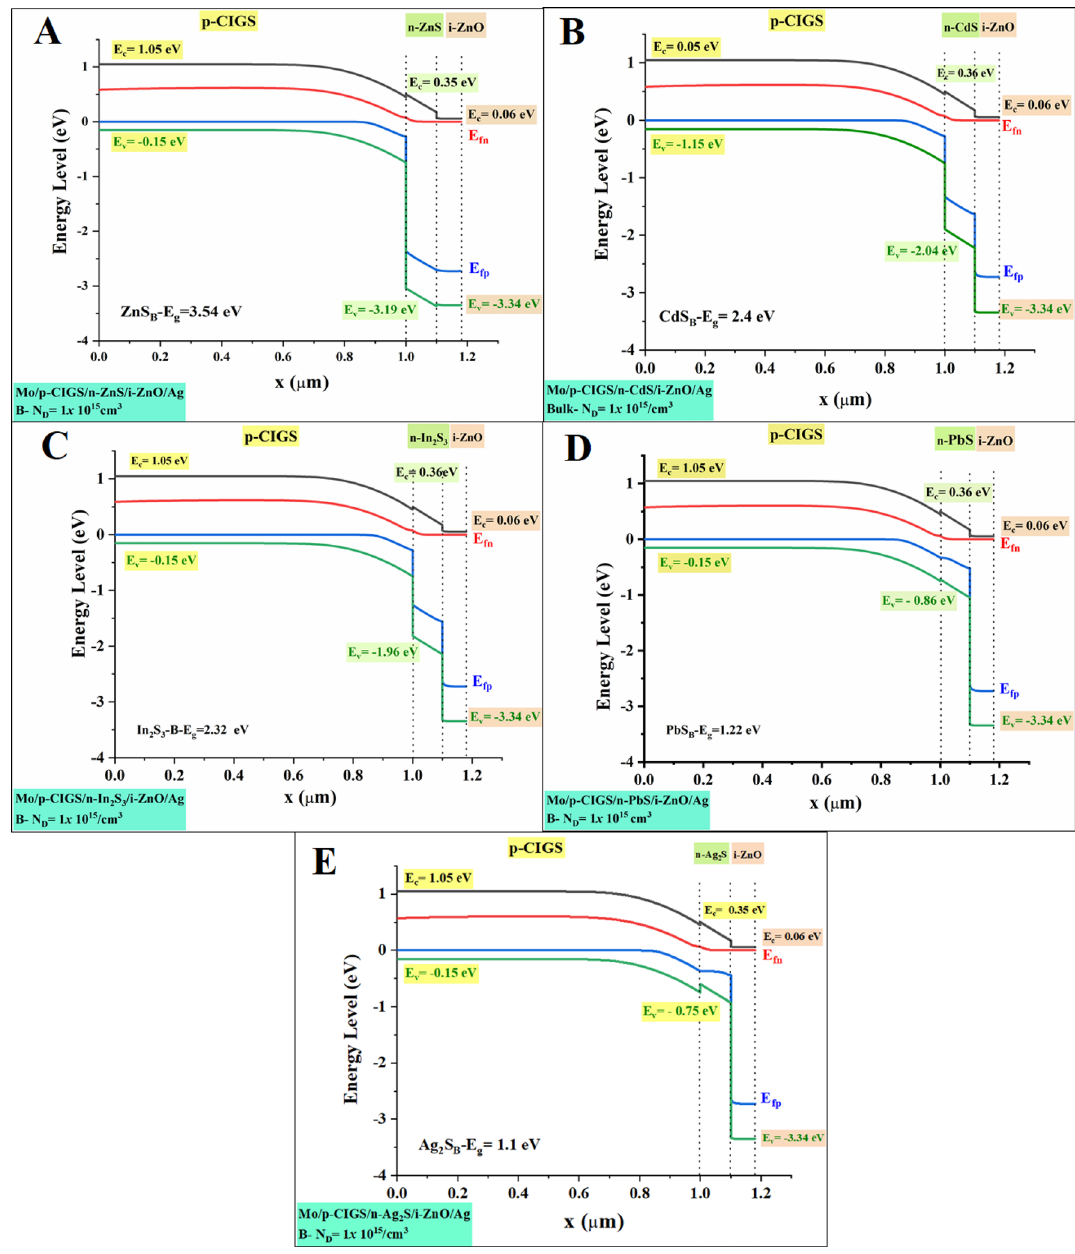
Figure 7. Band diagram at Bulk bandgap at N D = 10 15